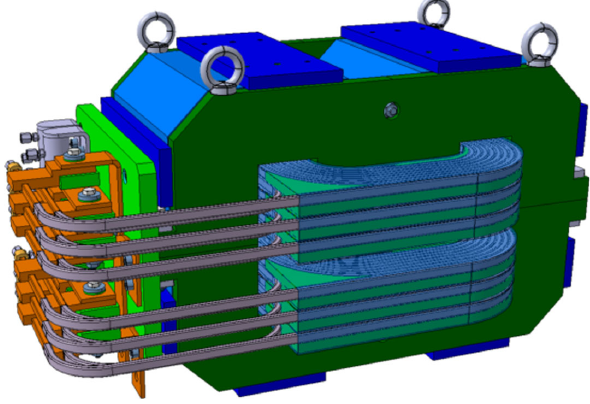
FIG. 5. Laminated straight H type TULIP dipole